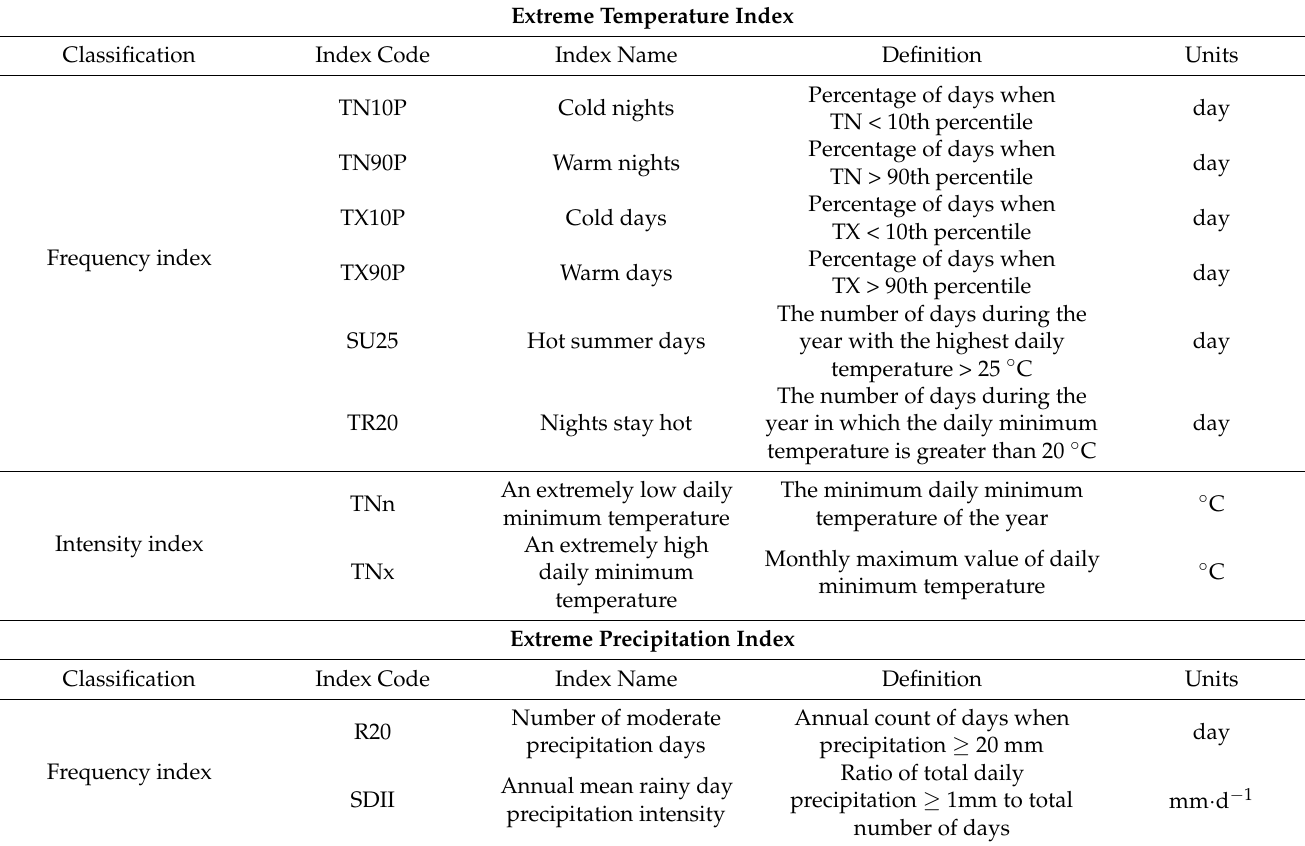
Table 1. Definition of the extreme climate index.